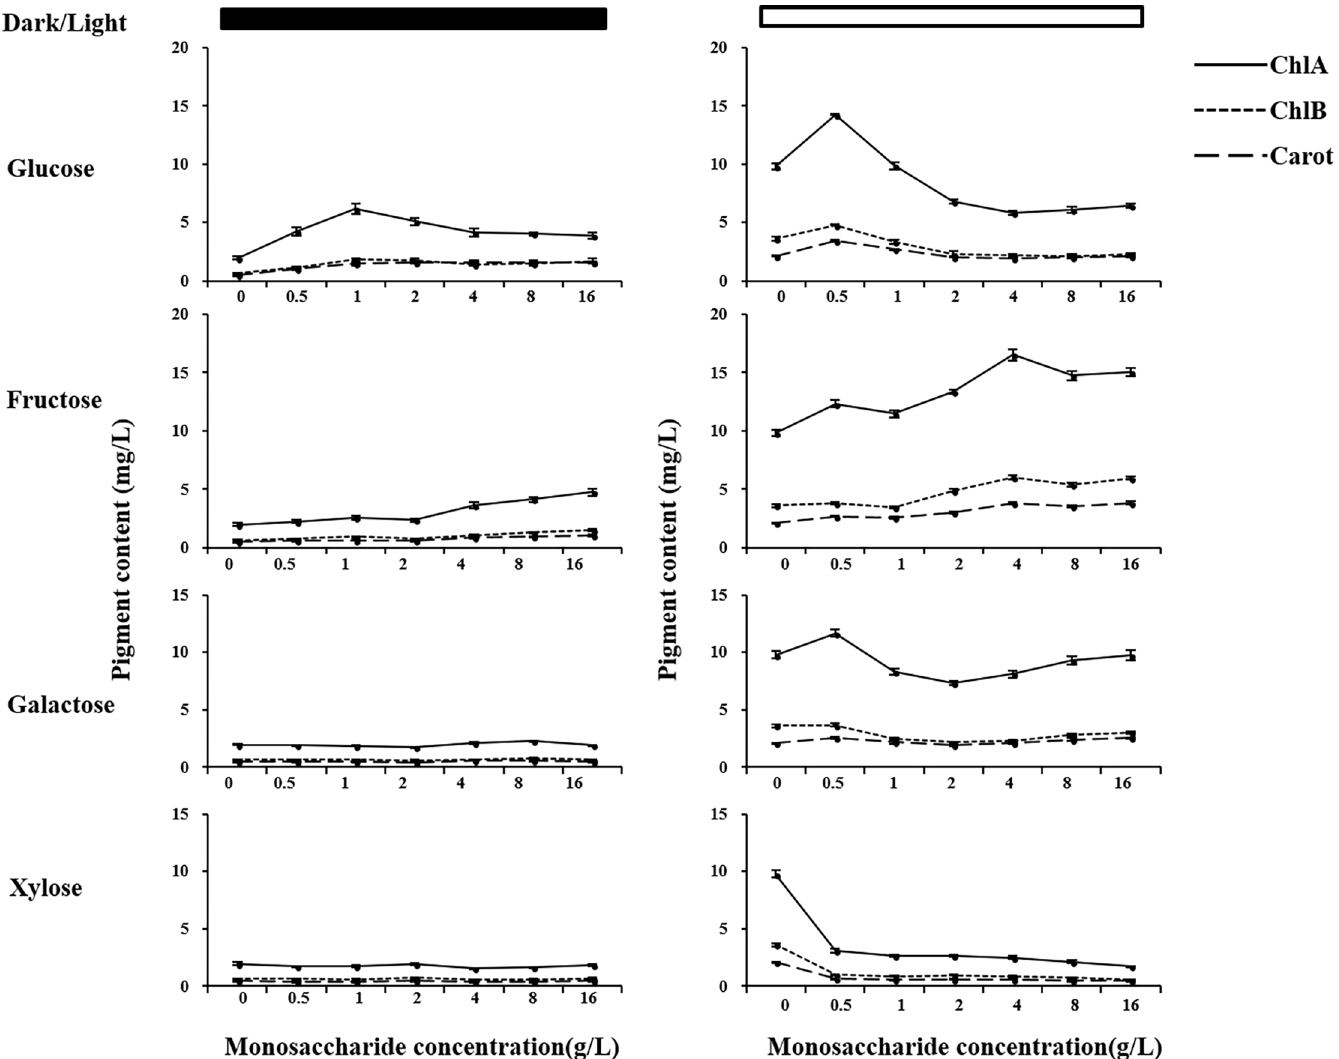
Fig 2. Pigment contents of Chlorella . sorokiniana UTEX 1230 grown in monosaccharides-supplemented mediums. The contents of DMSO extracted pigment from C . sorokiniana UTEX 1230 were determined by the optical density under corresponding wavelength. The line graph was drawn, x- and y-axes on the graph correspond to monosaccharide concentration and pigment contents, respectively. The left panel (black bar) showed the pigment extracted from cultures under dark condition. The right panel (blank bar) showed the pigment extracted from cultures under light condition. Data shown as mean +/-SD, n = 3. ChlA: chlorophyll a; ChlB: chlorophyll b; Carot: total carotenoid.